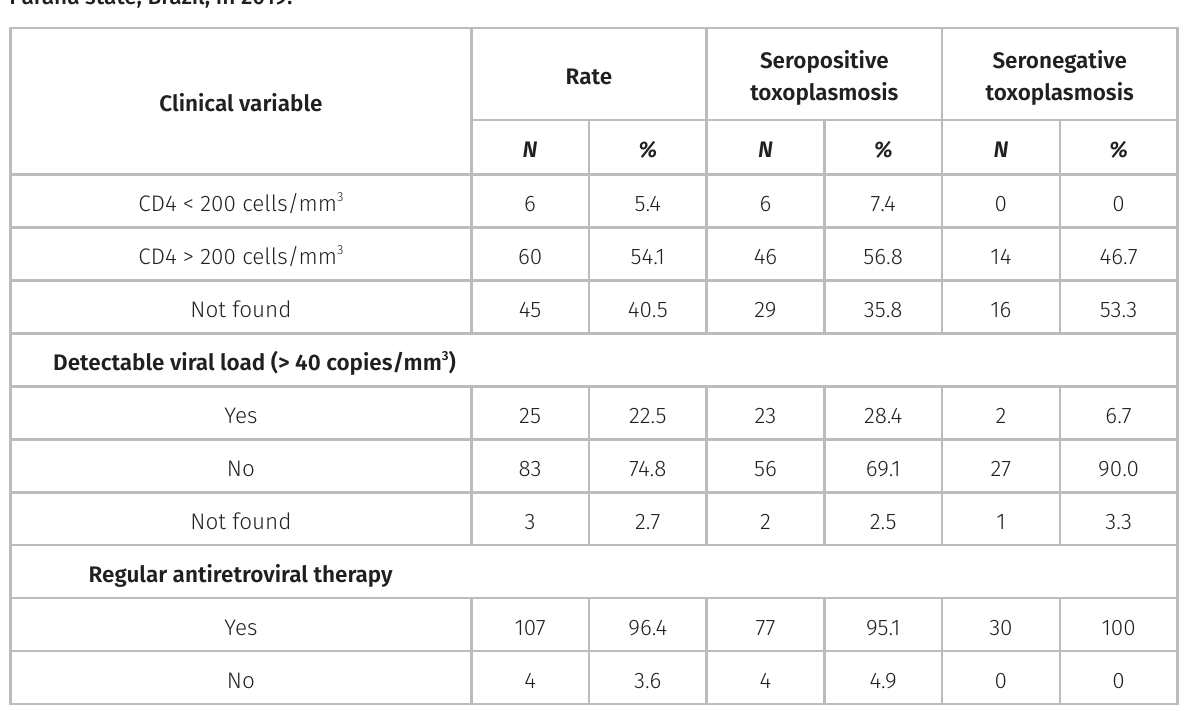
Table VI. Rate of T. gondii seropositivity and seronegativity and CD4 T-lymphocyte counts, viral load, and antiretroviral therapy in HIV patients who were attended by the Expert Assistance Service of Foz do Iguaçu city, Paraná state, Brazil, in 2019.